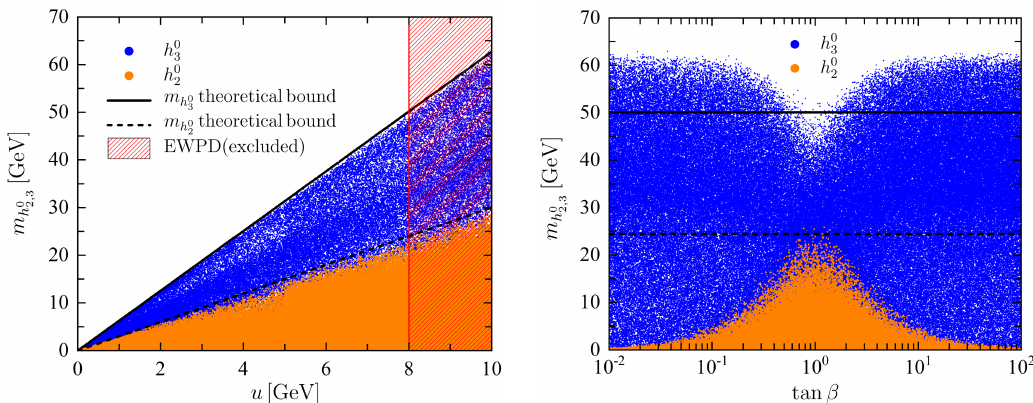
Figure 1 . Left: scatter plot of the lightest neutral-scalar masses vs. the triplet VEV u , in orange and blue for m and m , respectively. The solid (dashed) black line corresponds to the maximum h 0 2 h 0 3 value of the upper bounds given in eq. (3.27) at each value of u . Right: the same as in the left panel but now as function of tan β